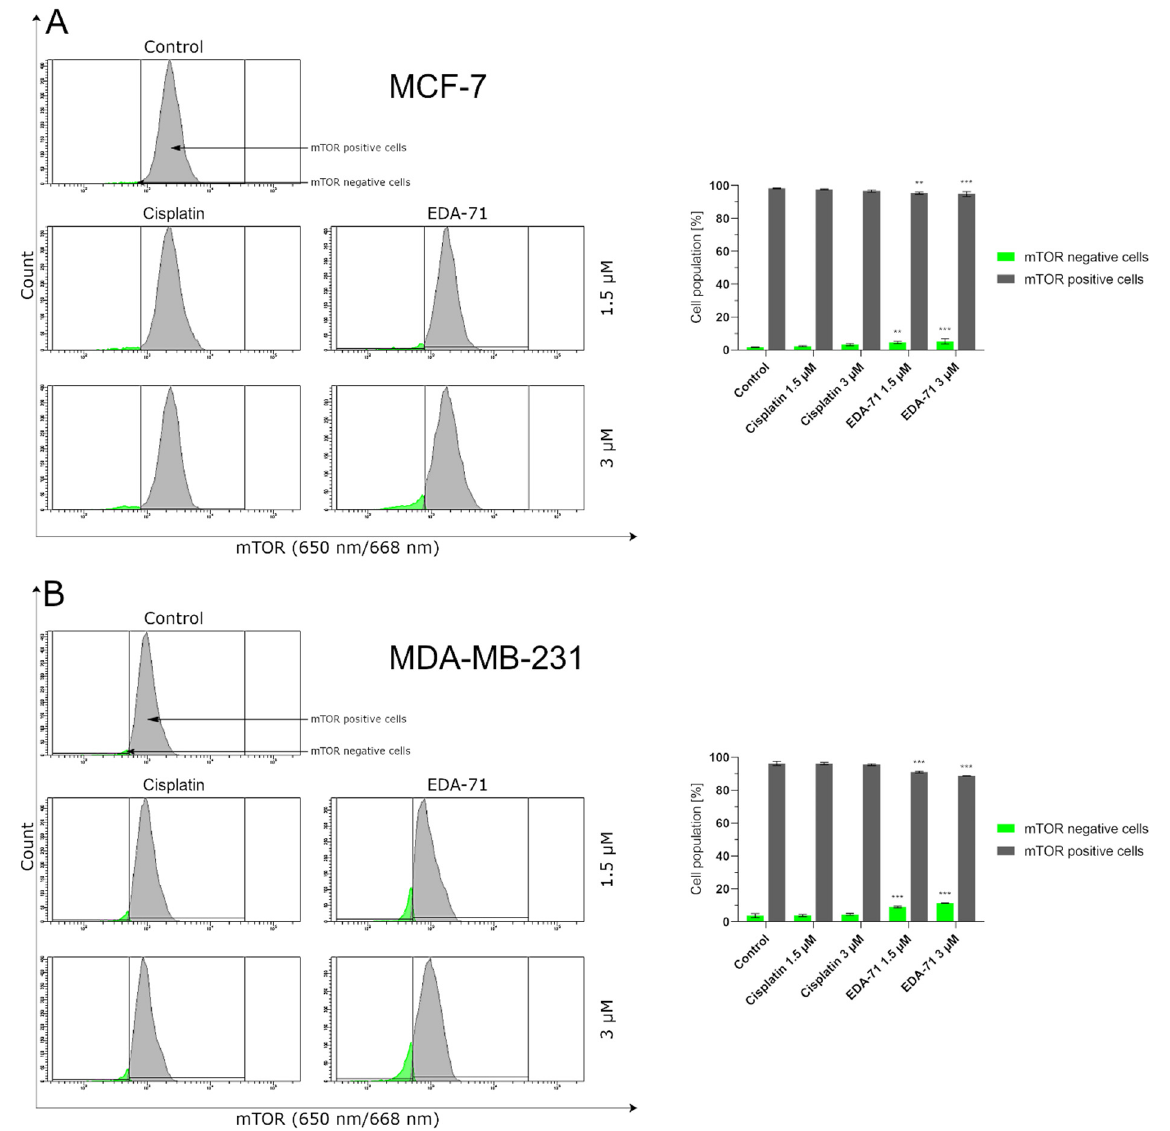
Figure 12. Cytometric analysis of mTOR activity in MCF-7 ( A ) and MDA-MB-231 ( B ) breast cancer cells after 24 h incubation with EDA-71 and cisplatin (1.5 and 3 µM). Results are presented as mean values ± SD obtained from three independent experiments ( n = 3) conducted in triplicate. Statistical differences between the experimental (treated cells) and control (untreated cells) groups were determined using one-way ANOVA followed by Dunnett’s test. ** p < 0.01 vs. control group, *** p < 0.001 vs. control group.